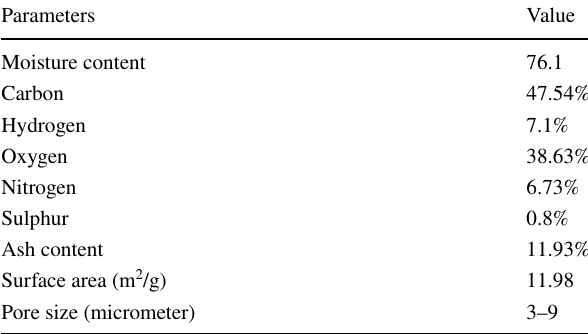
Table 2 Characteristics of parameters of algal